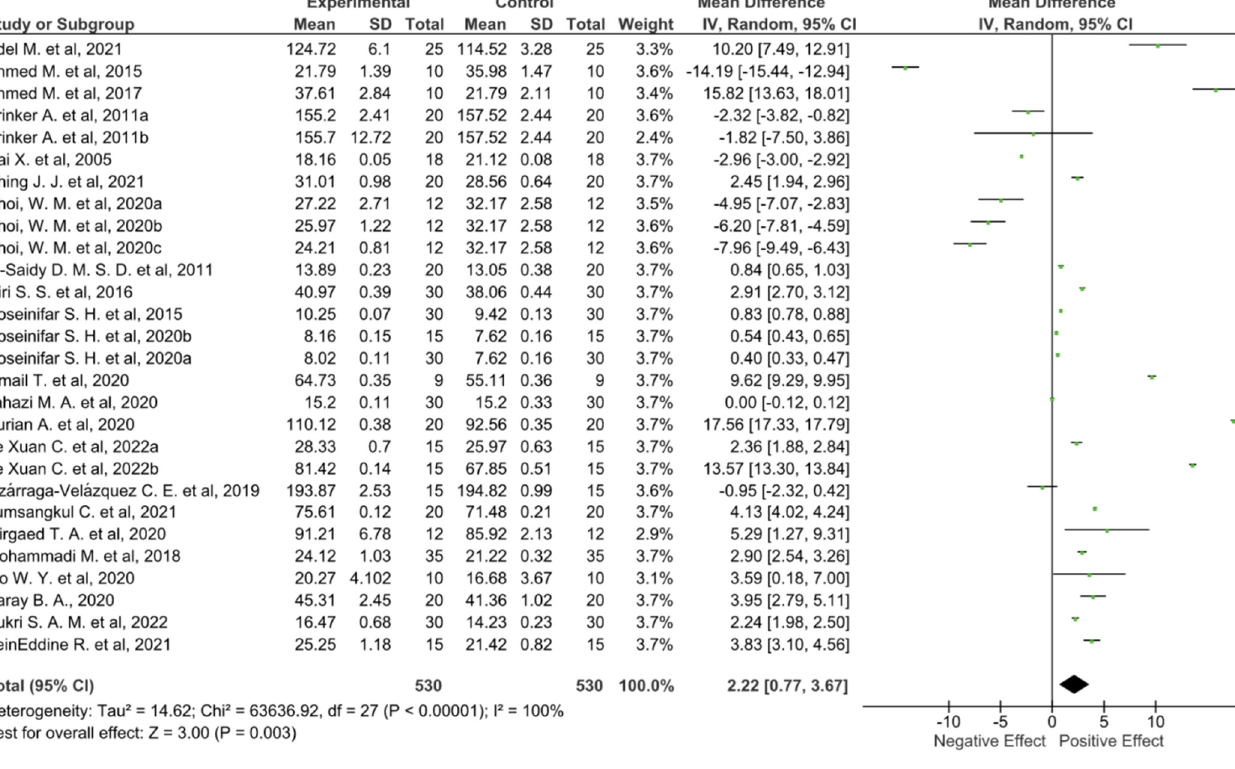
Figure 3. Forest diagram representation of the effects on fish growth performance resulting from supplementing fish diets with plant waste. Data were extracted from 26 articles [20,32–56], and plotted against the mean difference. Each horizontal line in the graph represents an individual and specific study, with the experimental mean value displayed as a green box. For each study, if the horizontal line (95% CI) crosses the vertical line (absence of effect), no statistically significant differences can be observed between the experimental and control group. The black diamond at the bottom of the forest plot represents the average effect size calculated from the combination of the results from all selected studies. The output was generated via Review Manager (RevMan) [Computer program]. Version 5.4. The Cochrane Collaboration,